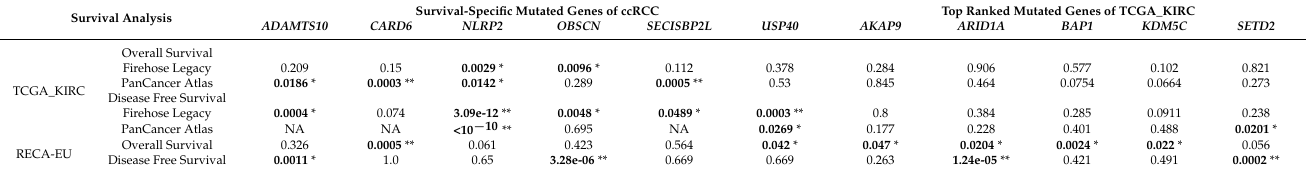
Table 6. Comparison of survival analysis of TCGA-KIRC and RECA-EU data for 11 clinicopathologi- cally significant mutated genes found in 22 Korean patients with clear cell renal cell carcinoma.